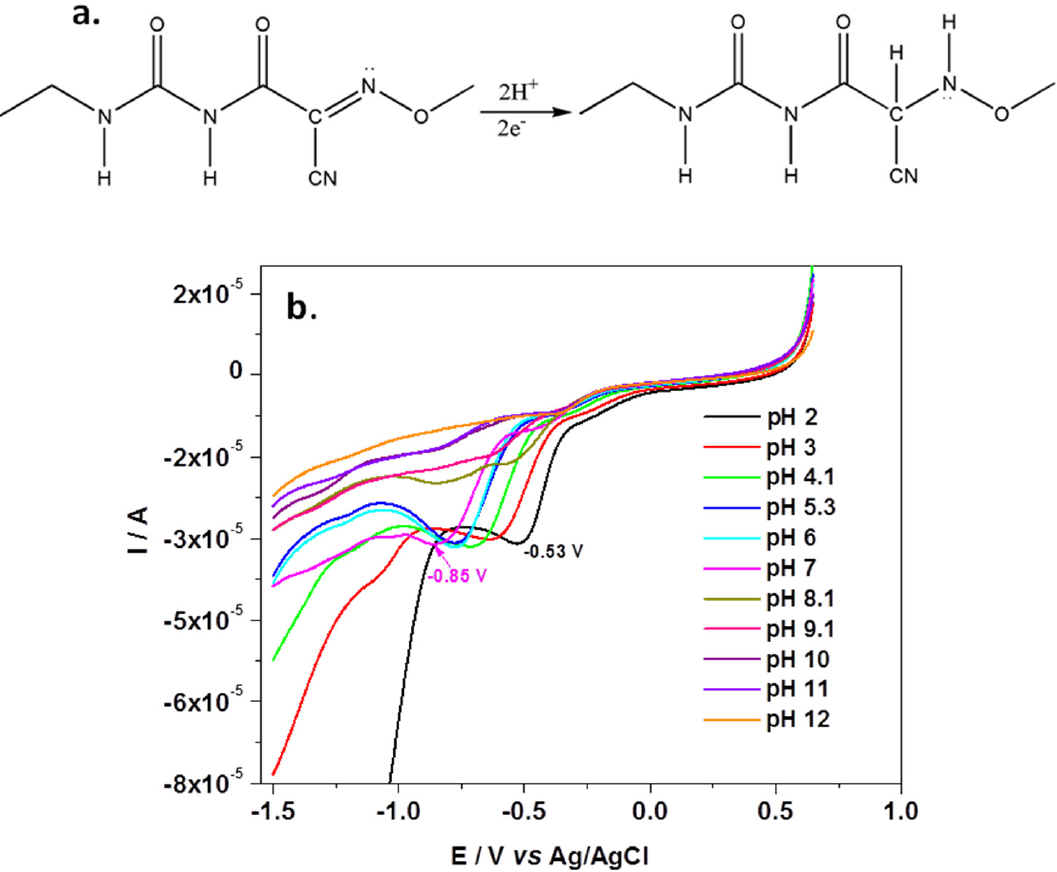
Figure 4. Electrochemical reduction of CYM ( a ); LSV recorded in BR solutions of various pH (2–12) each containing 10 − 3 M CYM; scan rate 10 mV/s ( b ) .